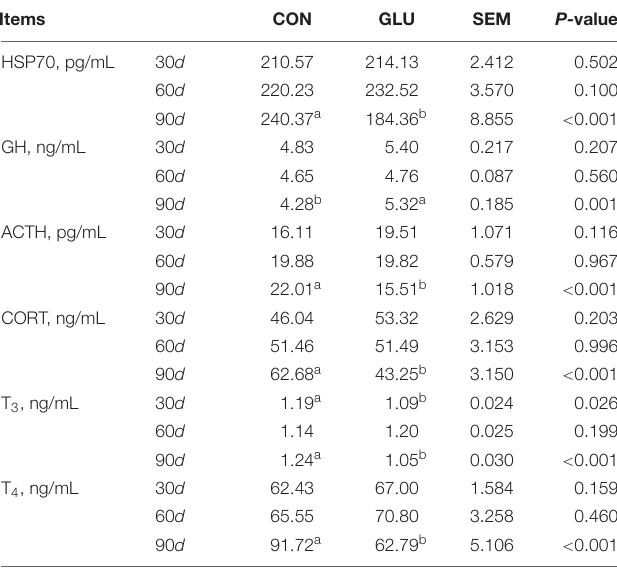
TABLE 8 | Effects of glutamate supplementation on serum hormone and HSP70 of heat-stressed Hu sheep ( n = 6) 1 . Items CON GLU SEM P-